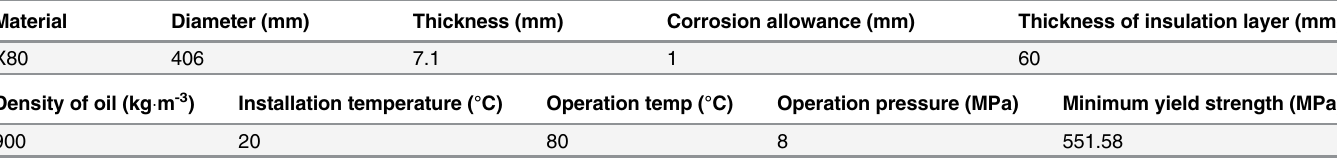
Table 3. Pipeline parameters.